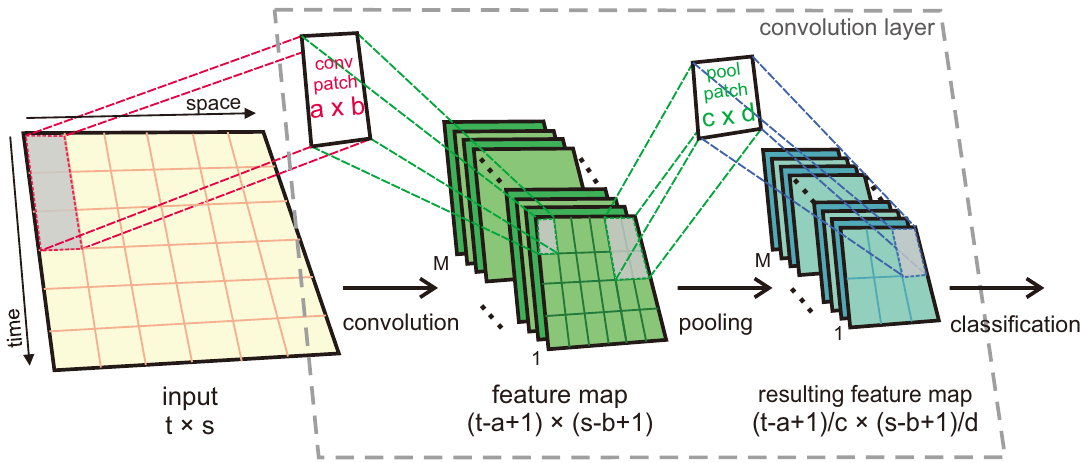
Figure 2. Structure of a convolutional neural network (CNN) depicting the results of applying the convolution and pooling processes in the convolution layer for the input. Default pooling (non-overlapping) is shown in this